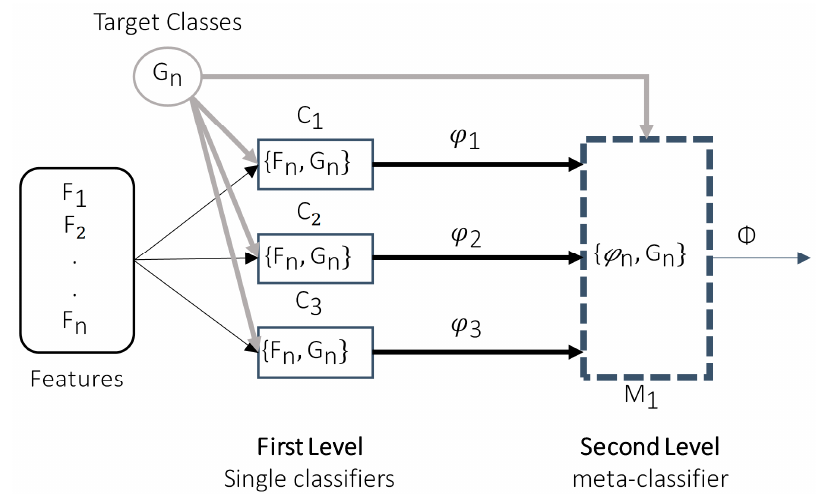
Figure 4. Stacking algorithm representation. In the first level, the features of the sEMG signals enter into the single classifiers (LDA, SVM or KNN); the results of these classifiers are the entry features of the metaclassifier, in this case, a KNN